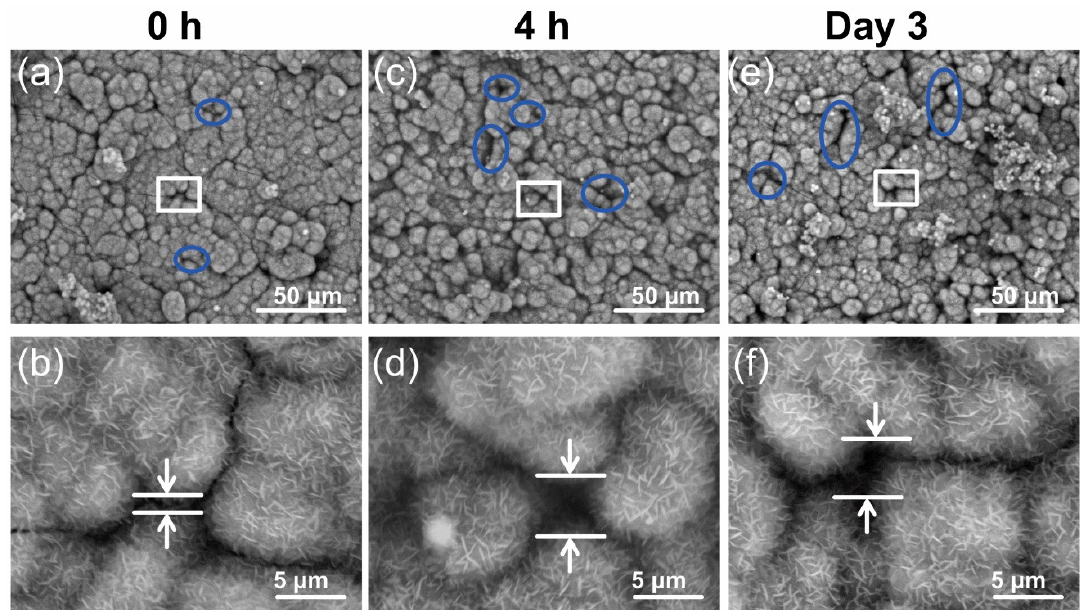
Figure 8. SEM imaging of (+A/+F)-bCaP(24 h) coated disk incubated in media with no cells: ( a , b ) AntiA-bCaP(24 h)-FGF2 before incubation in culture medium; ( c , d ) low and high magnification of +A/+F AntiA-bCaP(24 h)-FGF2 incubated in culture medium for 4 h; and ( e , f ) low and high magnification of +A/+F AntiA-bCaP(24 h)-FGF2 incubated in culture medium for three days. The white squares indicates the areas shown at higher magnification in the row below. Blue circles highlight the openings between crystal junctions that widened with time in culture medium.